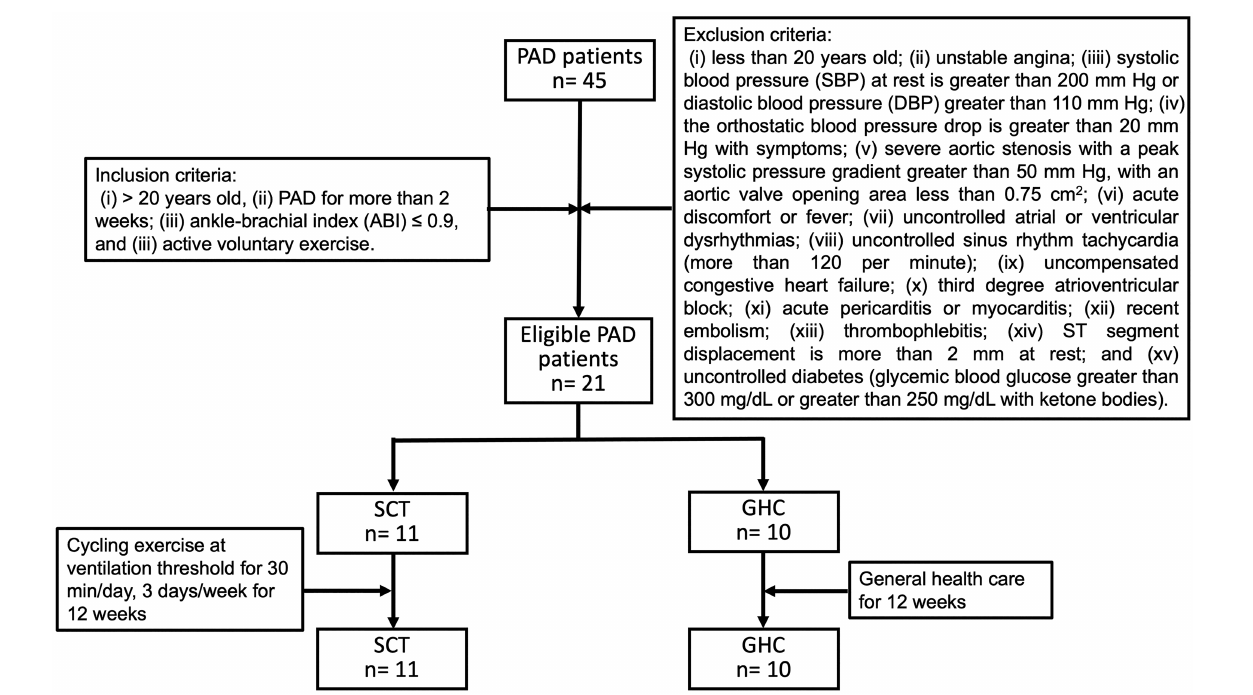
FIGURE 1 | Flowchart of participants with peripheral arterial disease (PAD) during follow-up. Recruited PAD patients were divided into two groups: supervised cycling training (SCT) and general healthcare (GHC). The SCT group performed supervised hospital-based training on a bicycle ergometer (i.e., cycling exercise at ventilation threshold for 30 min/day, 3 days/week for 12 weeks). The GHC group had only general healthcare for 12 weeks, as instructed by their